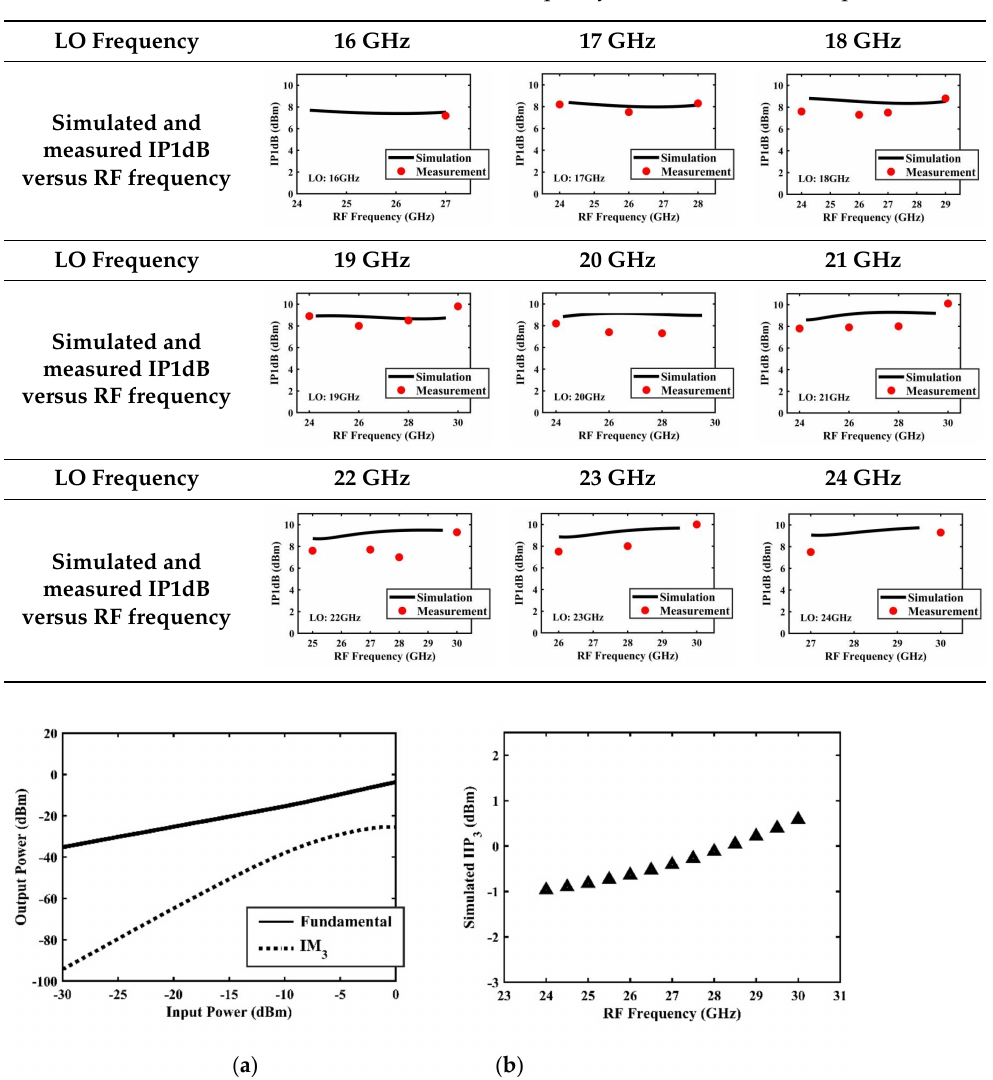
Table 4. Simulated and measured IP1dB versus RF frequency under different LO frequencies.